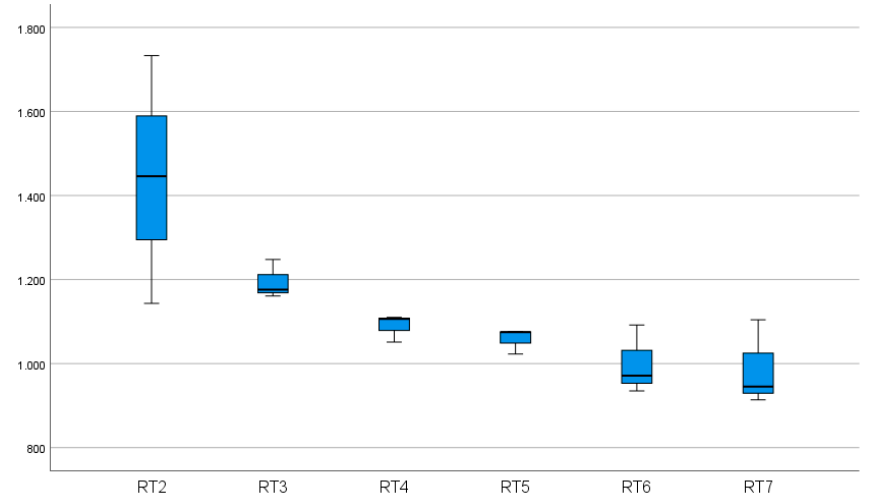
Figure 11. The sum of the reaction times of 10 participants as a function of the stereo acuity level before training. Forty-sixarcseconds (RT2/level 2) represented the most difficult level and 368 arcsec (RT7/level 7) the easiest level.